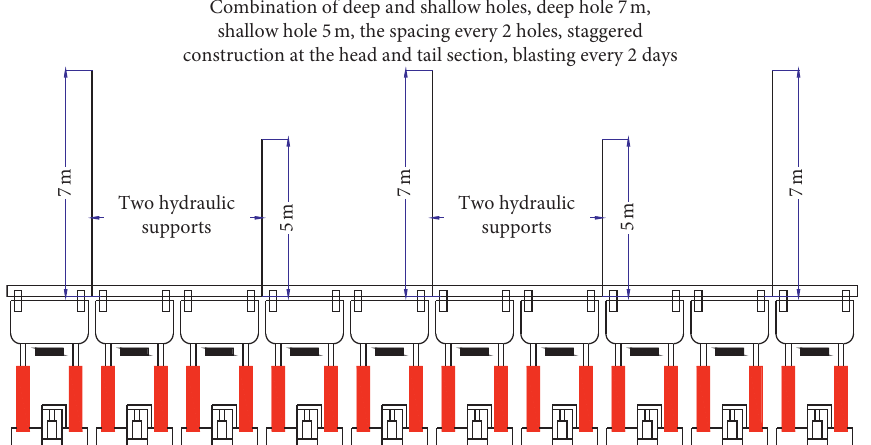
Figure 12: Layout of pressure relief holes in the working face roof.